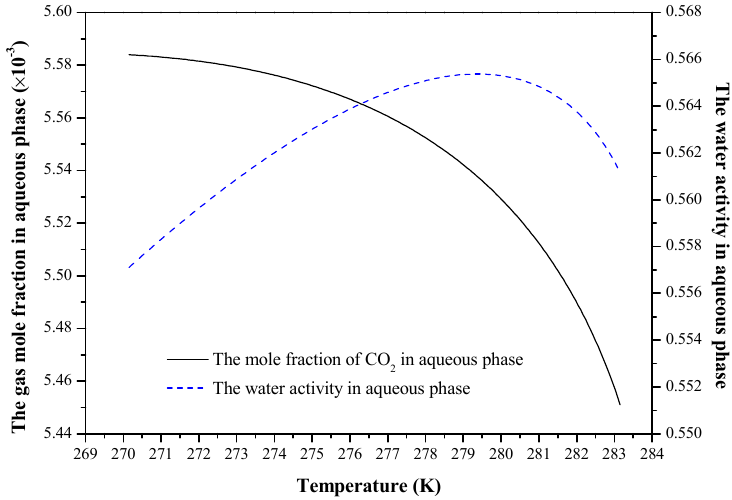
4 and water activity in aqueous phase.